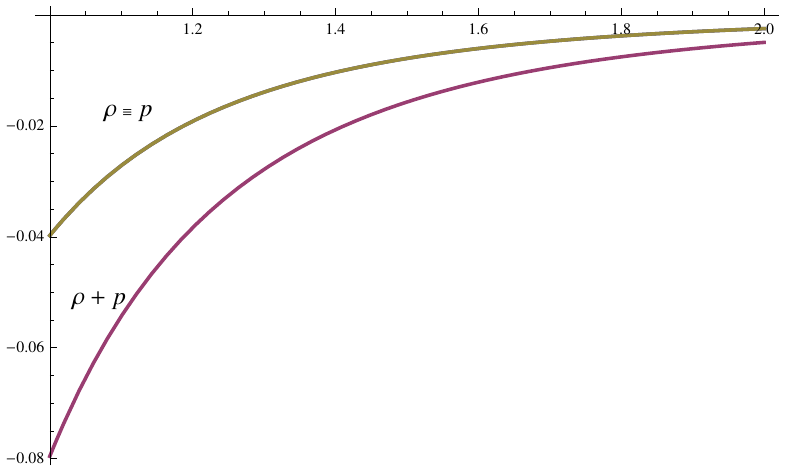
Figure 1. Plot of ρ ≡ p r and ρ + p r , as functions of the coordinate r , in Planckian units, for ξ = 0 and r 0 = 1.